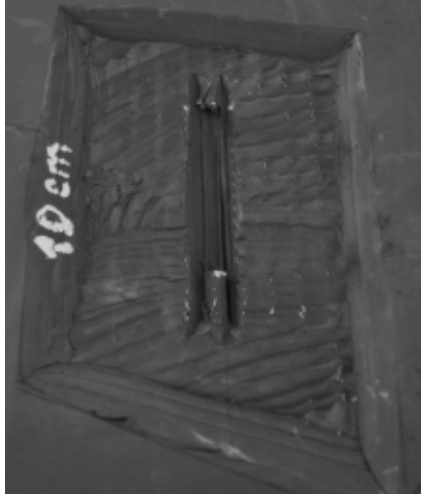
Figure 7. Example of the damage induced to the conveyor